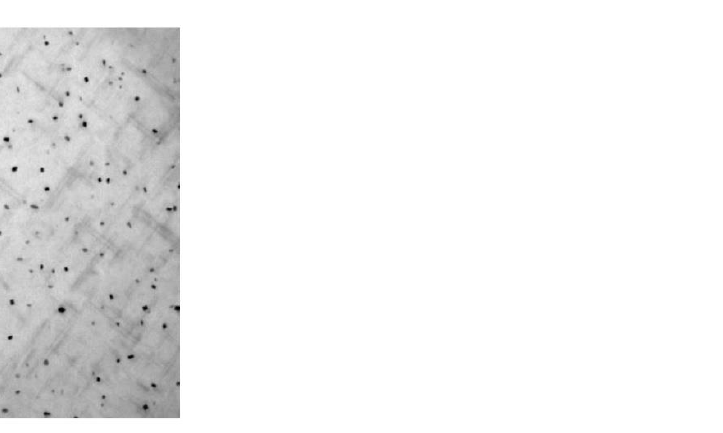
Figure 6. Bright-field TEM images of the as-solutionized alloy aged at 180 °C for 8 h with zone axis [001] Al.